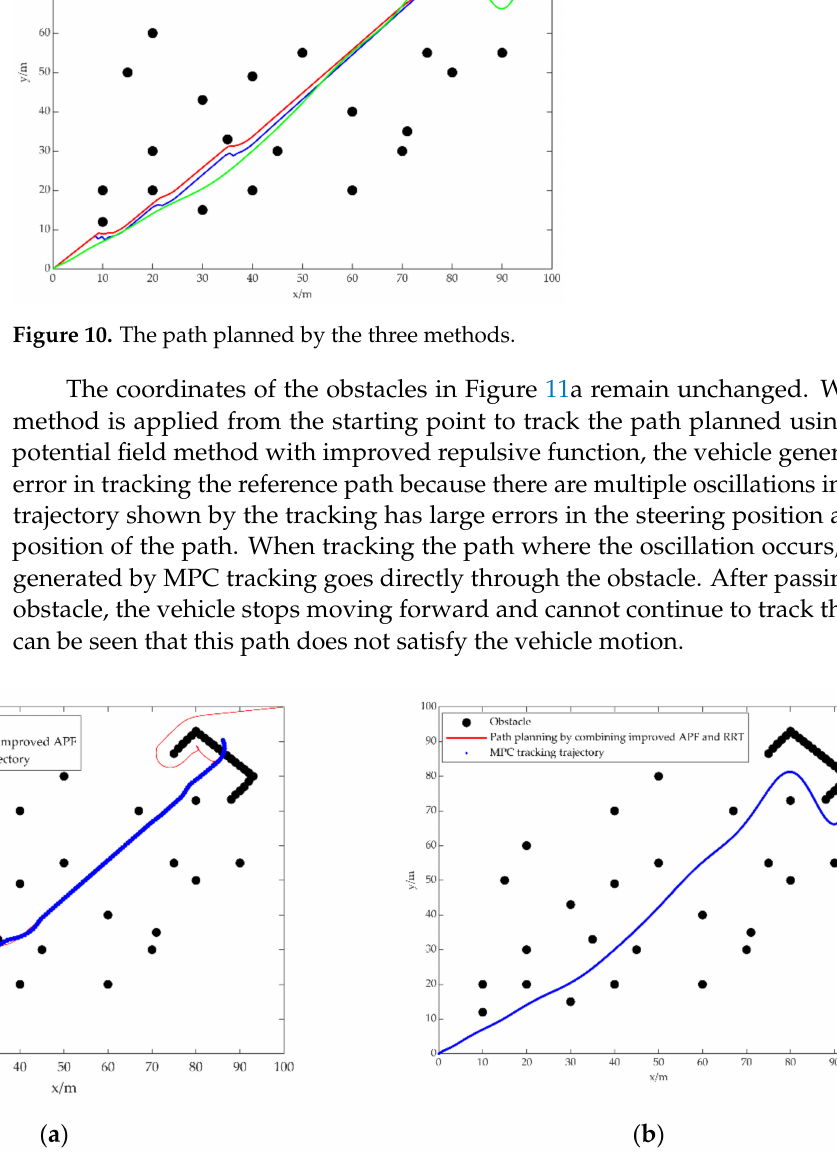
Figure 11. ( a ) MPC tracks the trajectory planned by the improved APF method; ( b ) MPC tracks the trajectory planned by the combination of the improved APF method and the RRT